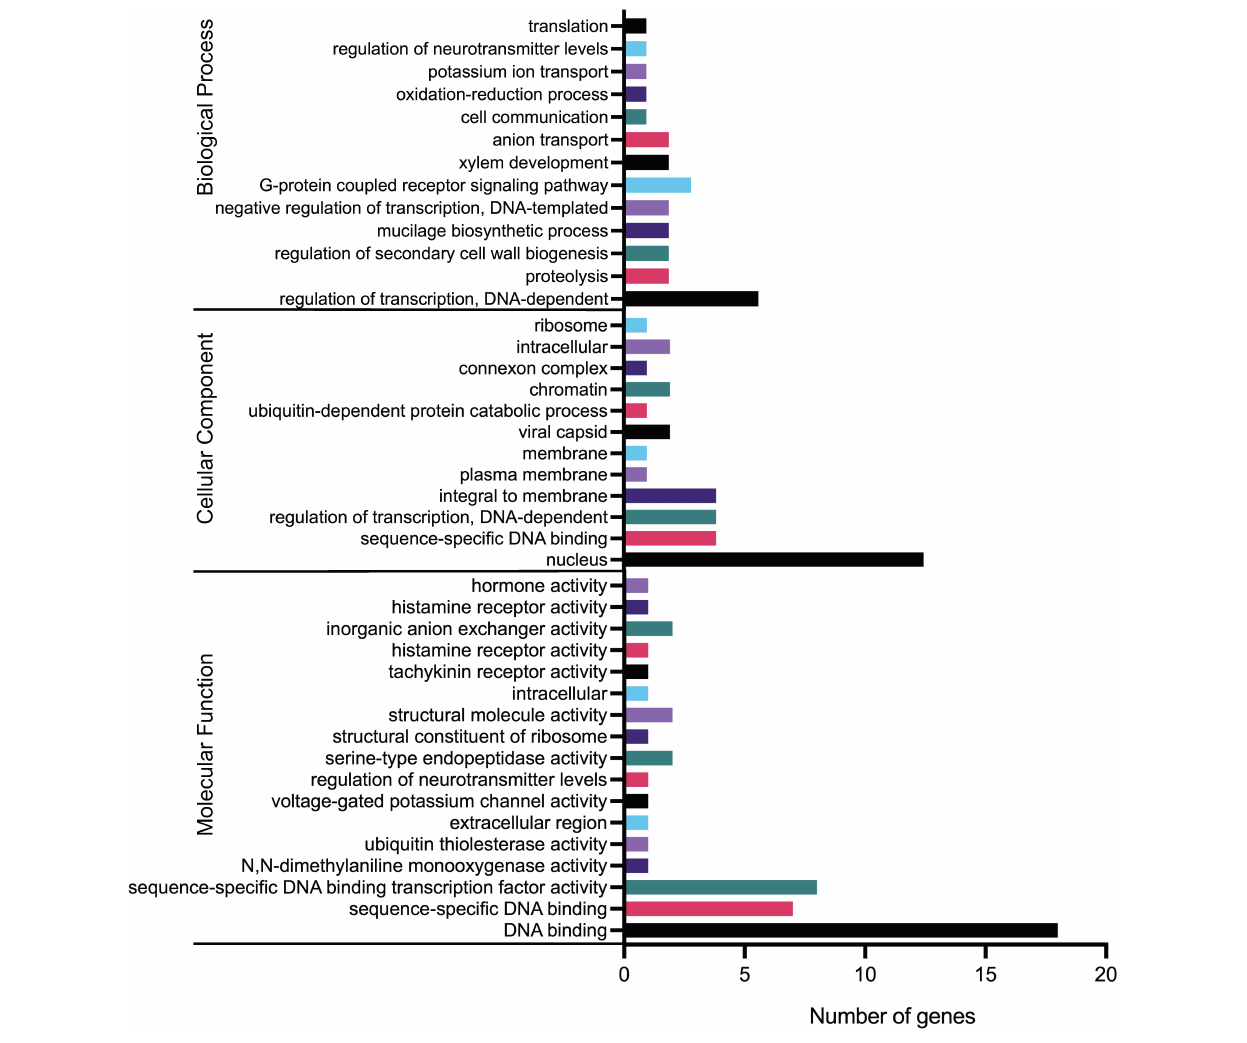
FIGURE 8 | Gene ontology (GO) terms of orchid KNOX genes. Annotation details for each gene are listed in Supplementary Table 7